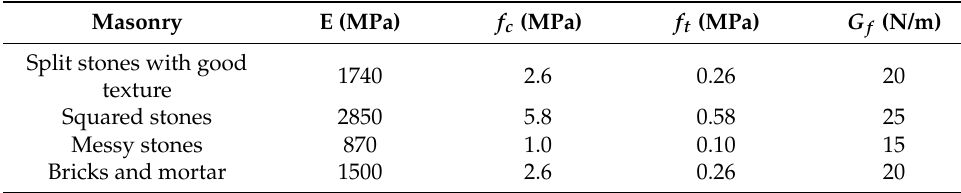
Table 1. Masonry’s assumed static material